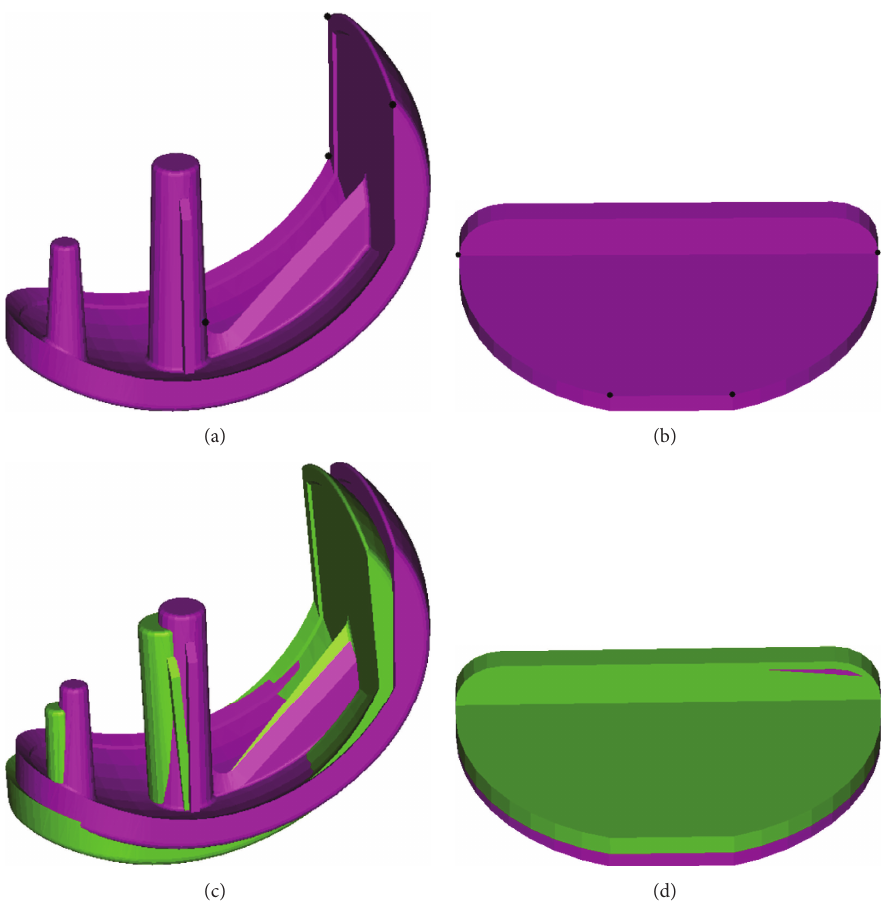
Figure 1: Four points selected on the (a) femoral and (b) tibial implants to construct the local frame of reference. Comparison of the planned versus achieved rotational and translational errors based on the local frame of reference for (c) femoral and (d) tibial implants.